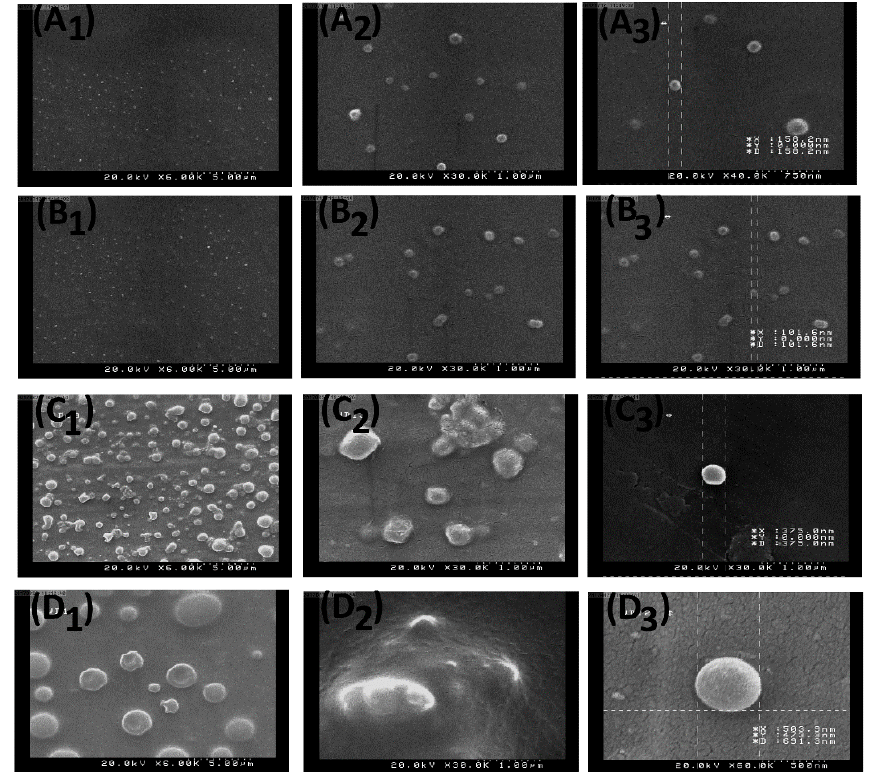
Figure 3. FE-SEM images of the nanoparticles (NPs) with different concentration ratios: ( A 1 ) 0.1% of PLGA at 6000×, ( A 2 ) 0.1% of PLGA at 30,000×, ( A 3 ) a size representation of 0.1% of PLGA NP at 40,000×, ( B 1 ) 0.2% of PLGA at 6000×, ( B 2 ) 0.2% of PLGA at 30,000×, ( B 3 ) a size representation of 0.2% of PLGA NP at 30,000×, ( C 1 ) 0.3% of PLGA at 6000×, ( C 2 ) 0.3% of PLGA at 30,000 X, ( C 3 ) a size representation of 0.3% of PLGA NP at 30,000×, ( D 1 ) 0.5% of PLGA at 6000×, ( D 2 ) 0.5% of PLGA at 30,000× and ( D 3 ) a size representation of 0.5% of PLGA NP at 60,000×.